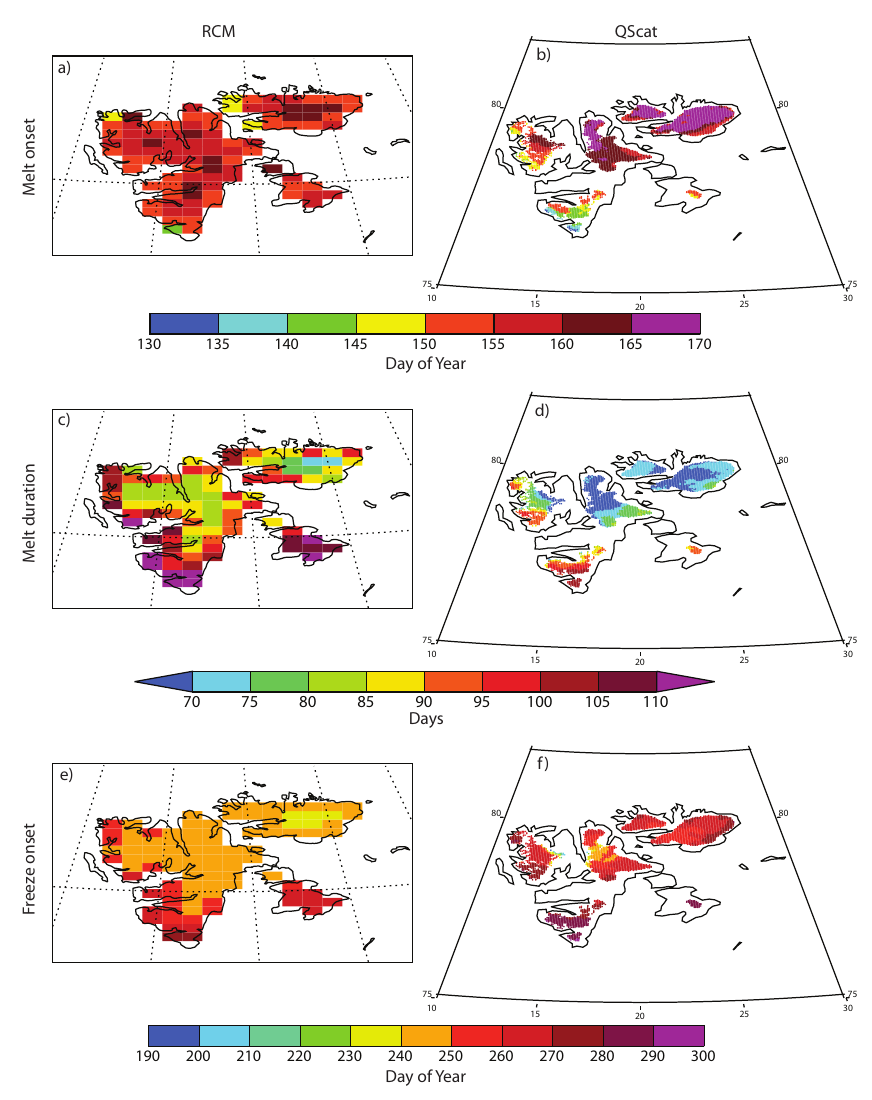
Fig. 4. Modelled and observed climatology of melt onset (a and b) , melt season duration (c and d) and freeze onset (e and f) . The model values are calculated from model days with positive